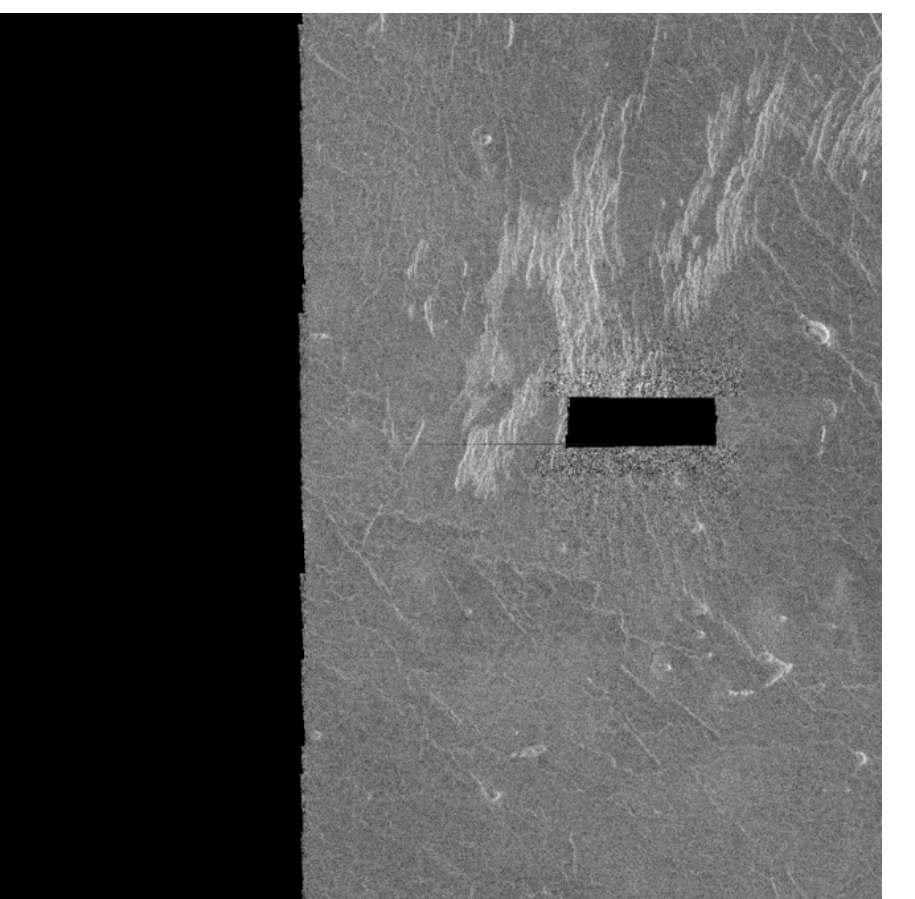
Figure 10. Examples of an image with a “black zone” [8].